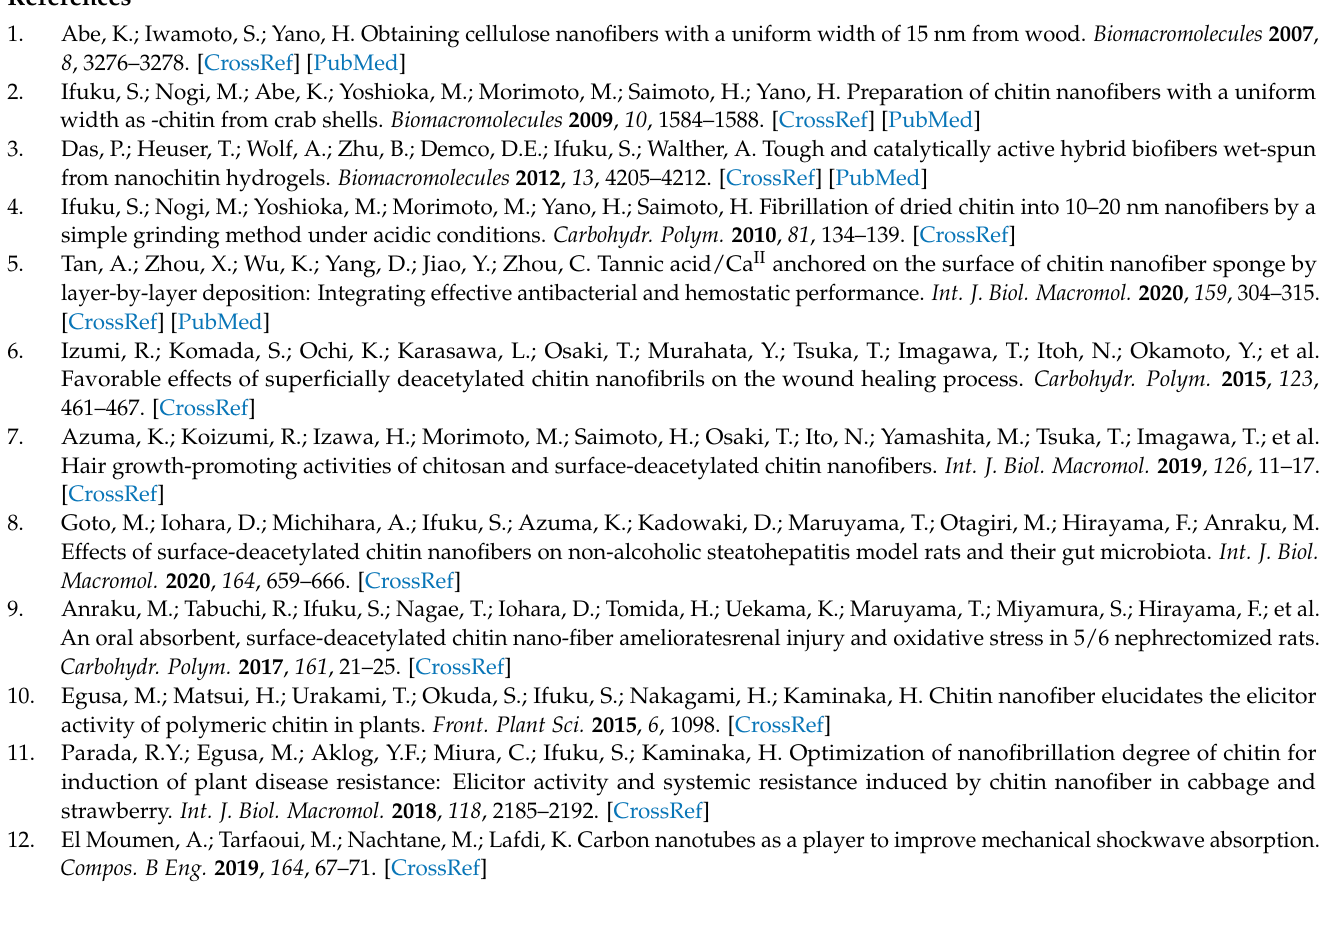
Figure S5: FE-SEM image of chitin nanofiber after milling for (a) 30, (b) 60, (c) 90, (d) 120, (e) 150, (f) 180 (g) 240, and (h) 300 min; Figure S6: AFM image of chitin nanofiber after milling for (a) 30, (b) 60, (c) 90, (d) 120, (e) 150, (f) 180 (g) 240, and (h) 300 min; Table S1: The weight and size of the milling ball and milling time used in each experiment for optimization of ball size; Table S2: The weight and size of the milling ball and milling time used in each experiment for optimization of total ball weight; Table S3: The weight and size of the milling ball and milling time used in each experiment for optimization of milling